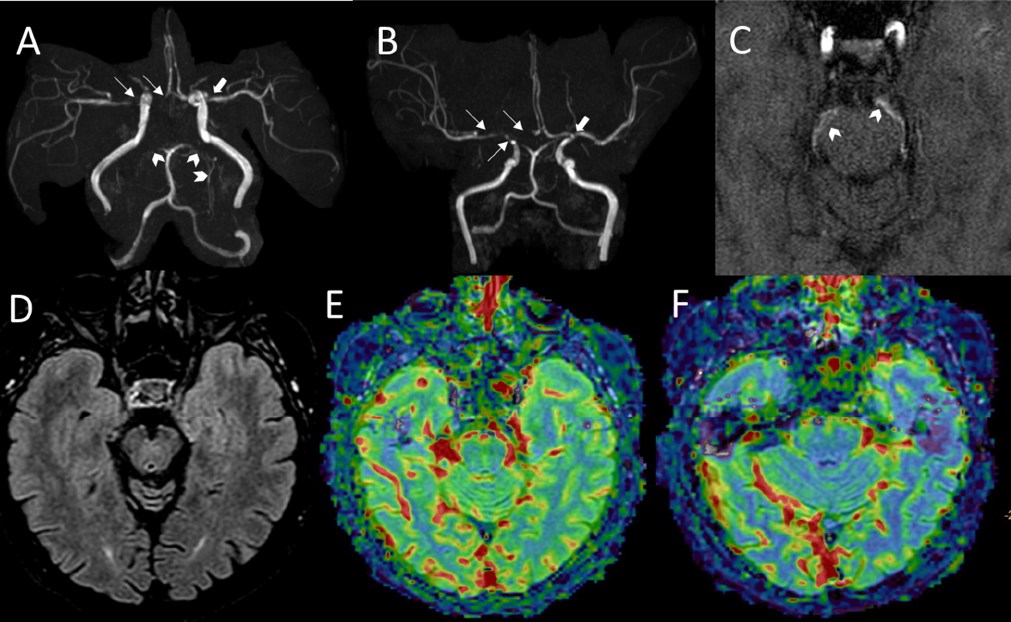
Figure 4. Imaging of maternal grandfather (I.1) from family B . Family B, patient I.1 ( A – F ): MRA images ( A – C ) showing severe stenosis of both the right ICA supraclinoid segment and the ipsilateral M1 segment, with signal loss of the right A1 segment (thin arrows in A , B ), with mild proximal stenosis of the left M1 segment (thick arrows in A , B ). Flow-related signal loss in distal opercular and sylvian branches is also visible bilaterally. Occlusion of PCAs with development of perimesencephalic thin collaterals are also evident (arrowheads in A – C ). FLAIR axial image at the level of temporo-occipital lobes and midbrain showing normal tissue signal ( D ). CBF and cerebral blood volume maps generated from dynamic susceptibility contrast-enhanced perfusion weighted imaging showing leptomeningeal and cortical signal reduction in the left temporo-occipital regions ( E , F ).